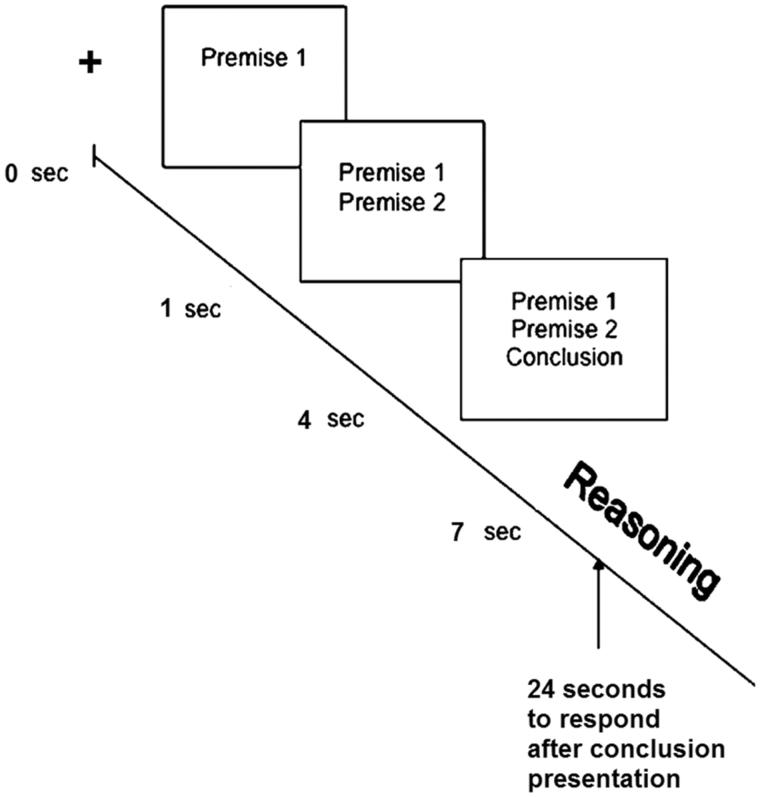
Time course of stimuli presentation.